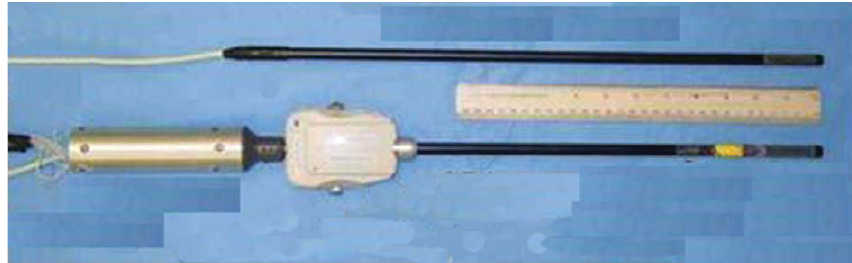
Fig. 2. The picture represents a normal Aloka (Aloka, Tokio, Japan) ultrasound probe for laparoscopic procedures (above), and the integration of the probe in the da Vinci Surgical System (Intuitive Surgical, Mountain View, CA, USA). This integration was performed by Leven and it is described in [14]. The Aloka probe has a diameter of 12mm and a length of 375